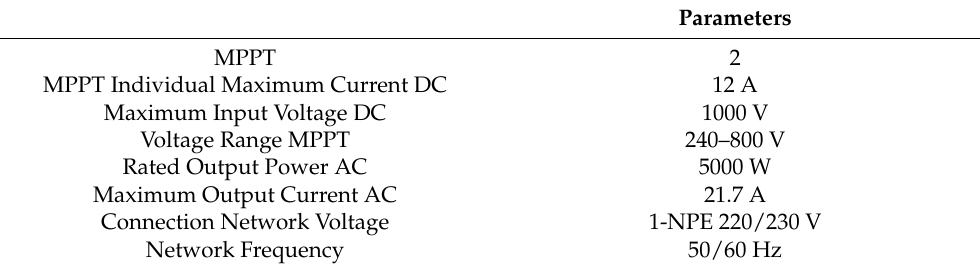
Table 3. Electrical parameters of the PV system inverter [29].